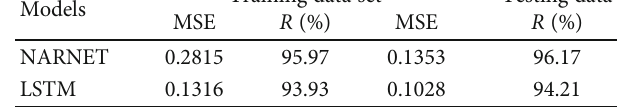
Figure 6: Histogram error of the NARNET